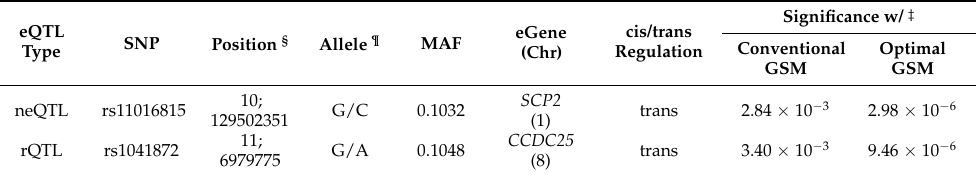
Table 2. Novel expression quantitative trait loci (eQTLs) resulted from a mixed model analysis employing the proposed genome similarity matrix *